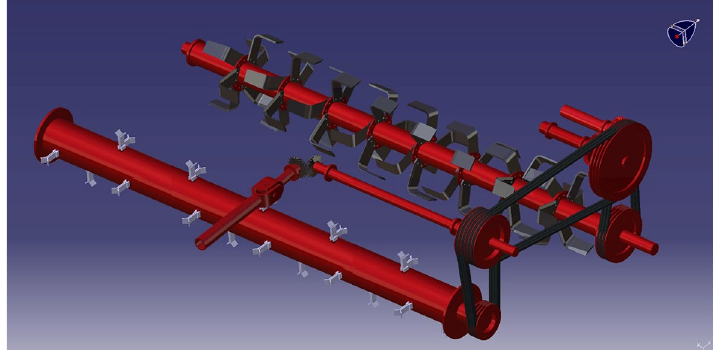
Figure 3. Isometric view of power transmission of a chopper cum incorporator